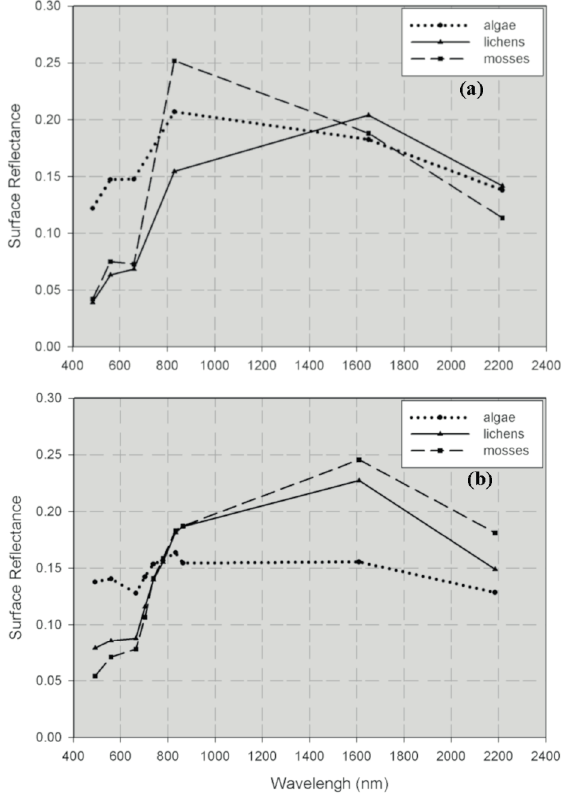
Figure 3. Average refl ectance patterns for biological soil crusts from Landsat (a) and Sentinel-2 (b)